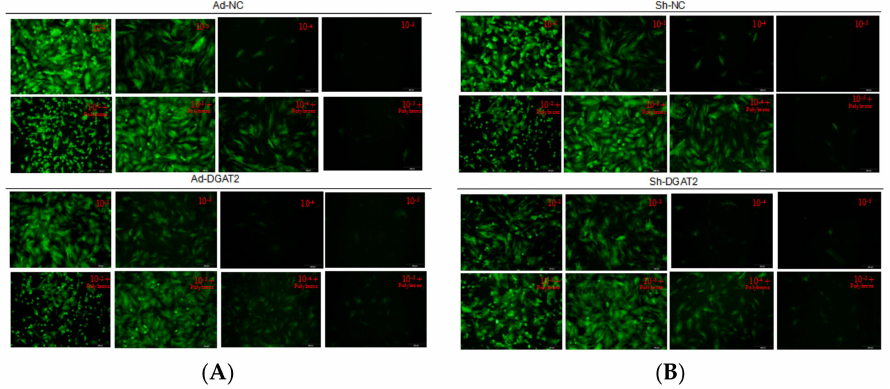
Figure 1. Green fluorescent expression of high titer adenovirus Ad-NC, Ad-DGAT2 ( A ) and sh-NC, sh-DGAT2 ( B ) infected bovine skeletal muscle satellite cells after 48 h. Scale bars = 200 µ